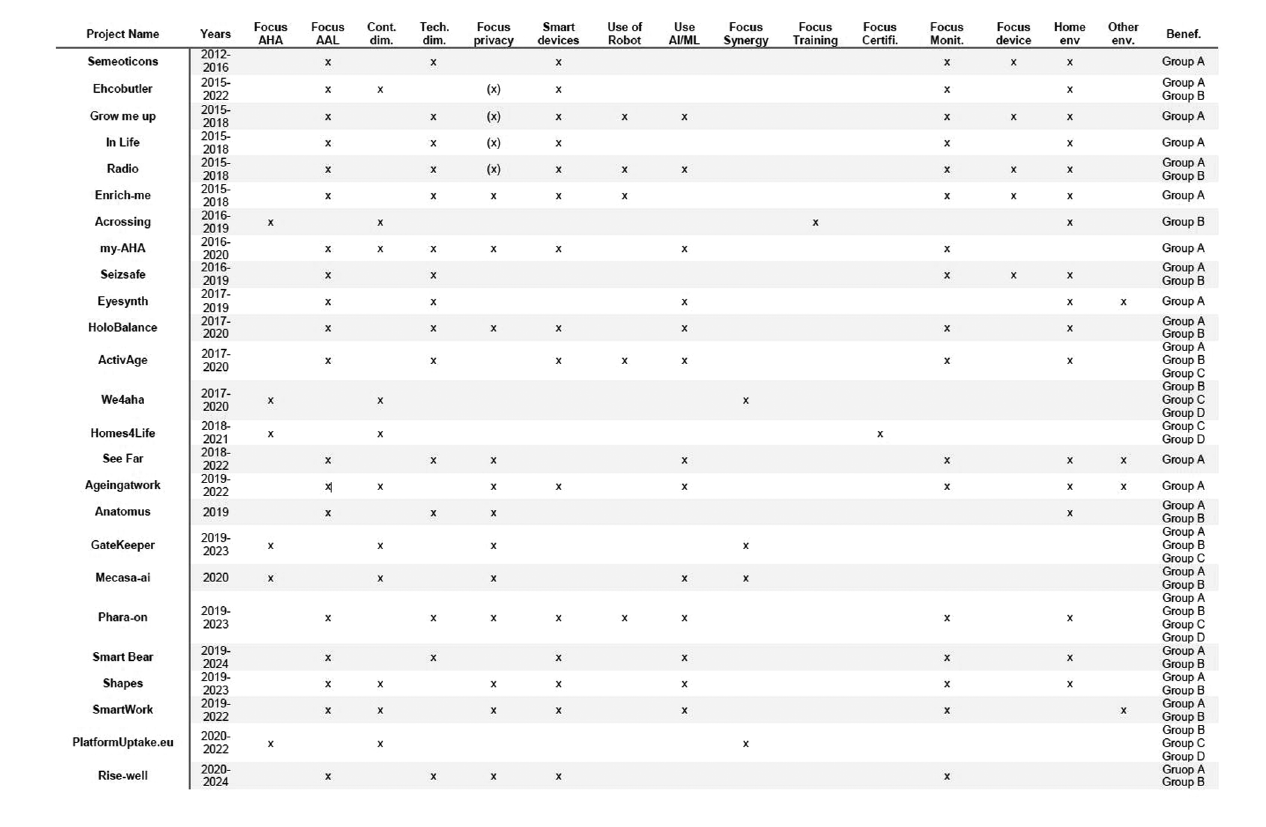
FIGURE 1 European projects in the AHA/AAL domain. AHA, Active Healthy Ageing; AAL, Active Healthy